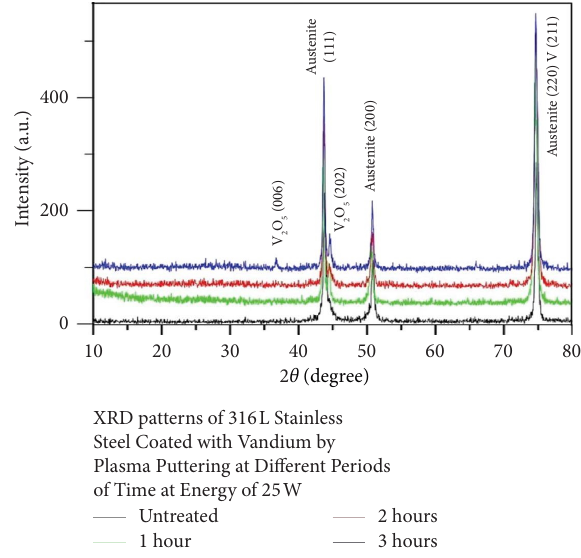
Figure 3: XRD patterns of 316L SS plasma sputtered with V at diferent sputtering